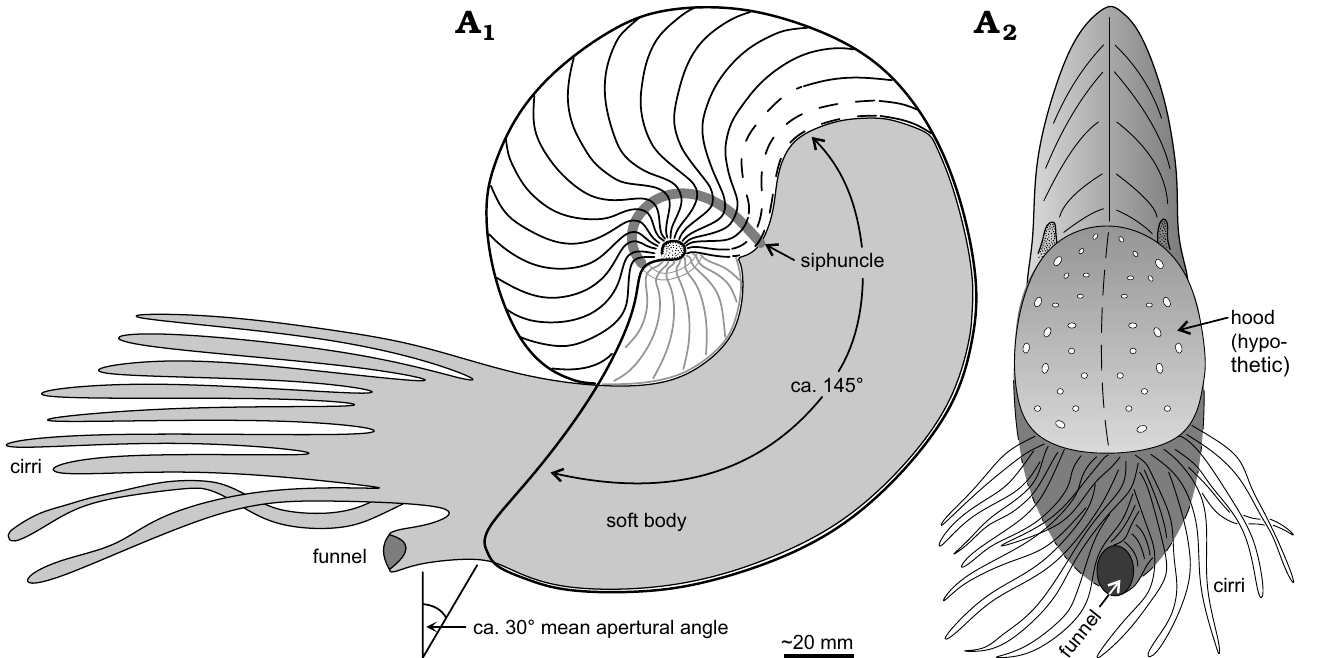
Fig. 9. Reconstruction of the life position of the hercoglossid nautilid Angulithes mermeti (Coquand, 1862) in sagittal cross-section (A 1 ) and apertural view (A 2 ) (approximately 1/2 of natural